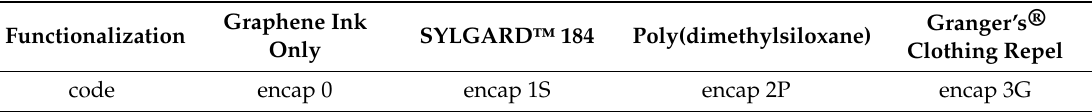
Table 1. Codes for functionalized